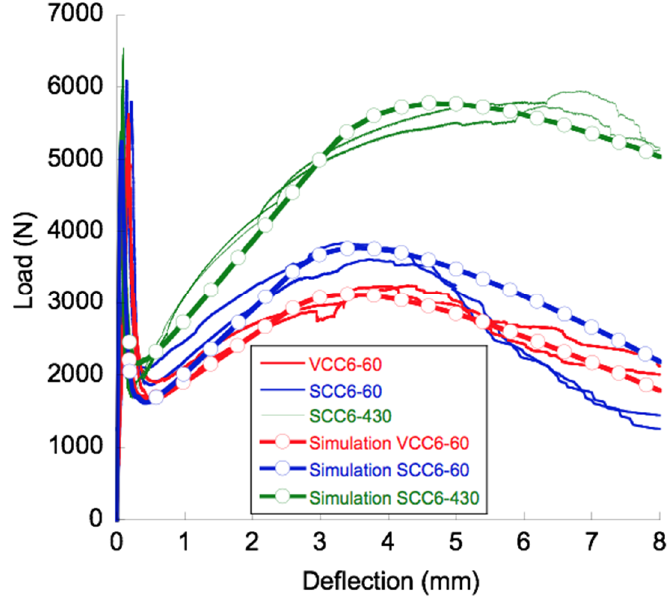
Figure 10. Results of the numerical simulations and the experimental tests.